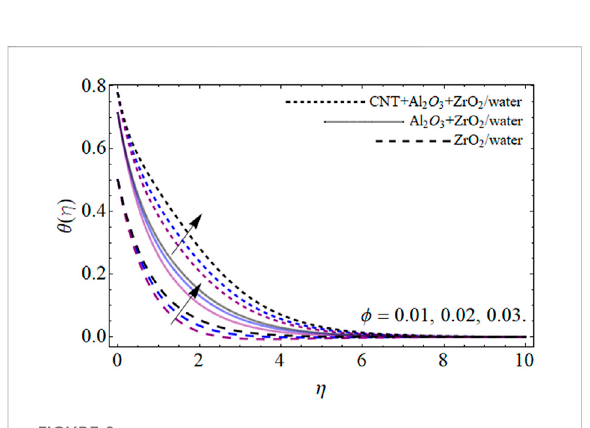
FIGURE 9 Energy outlines θ ( η ) versus ternary nanoparticles ϕ .